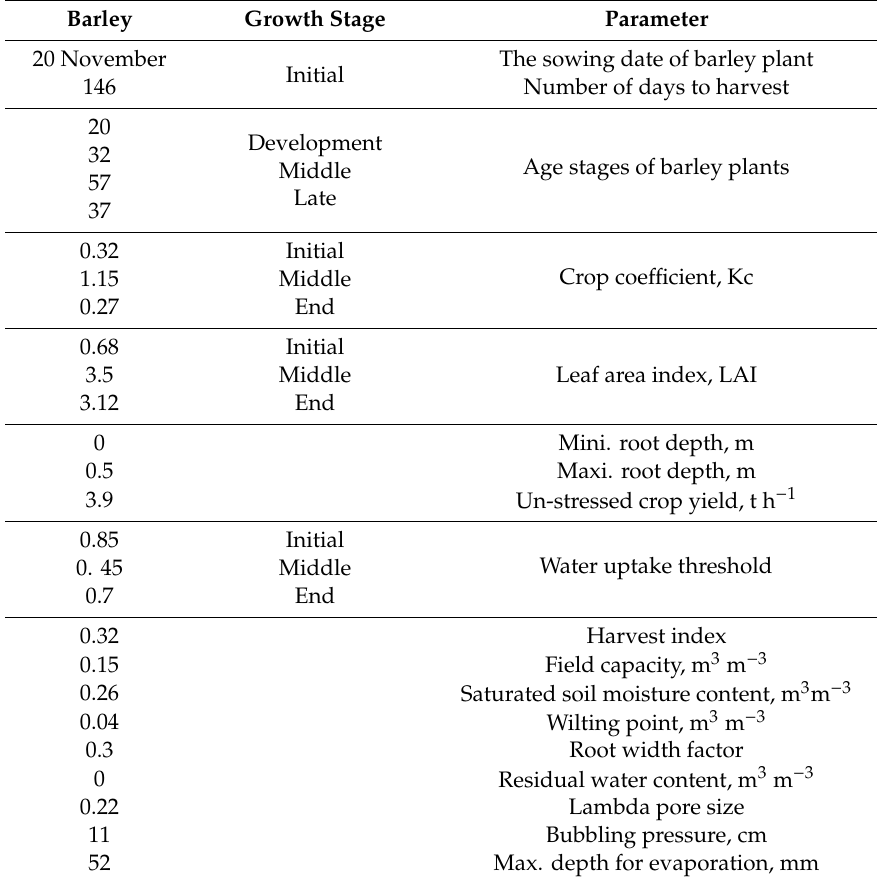
Table 6. The primaryinput parameters for barley for calibrating IW, 100%N (2017 / 2018), Egypt. Barley Growth Stage Parameter 20 November The sowing date of barley plant Initial